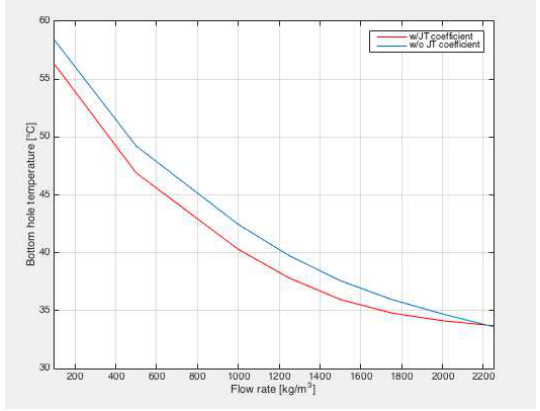
Figure 18: Bottom hole temperature vs. flow rate